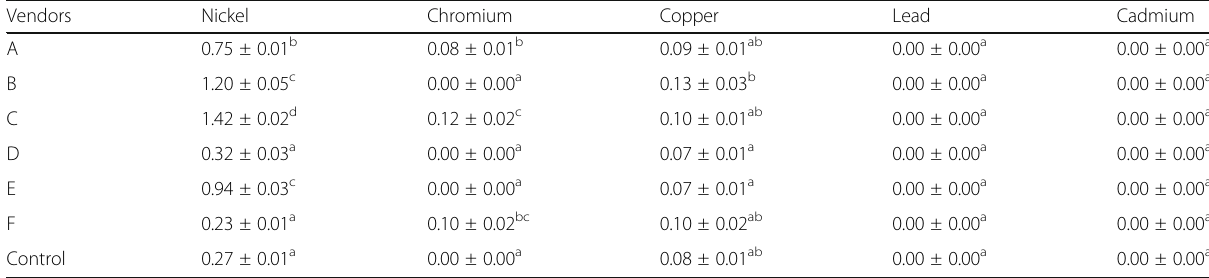
Table 3 Concentration (mgkg − 1 ) of heavy metals in sliced watermelon fruits purchased from Oja-Oba market Vendors